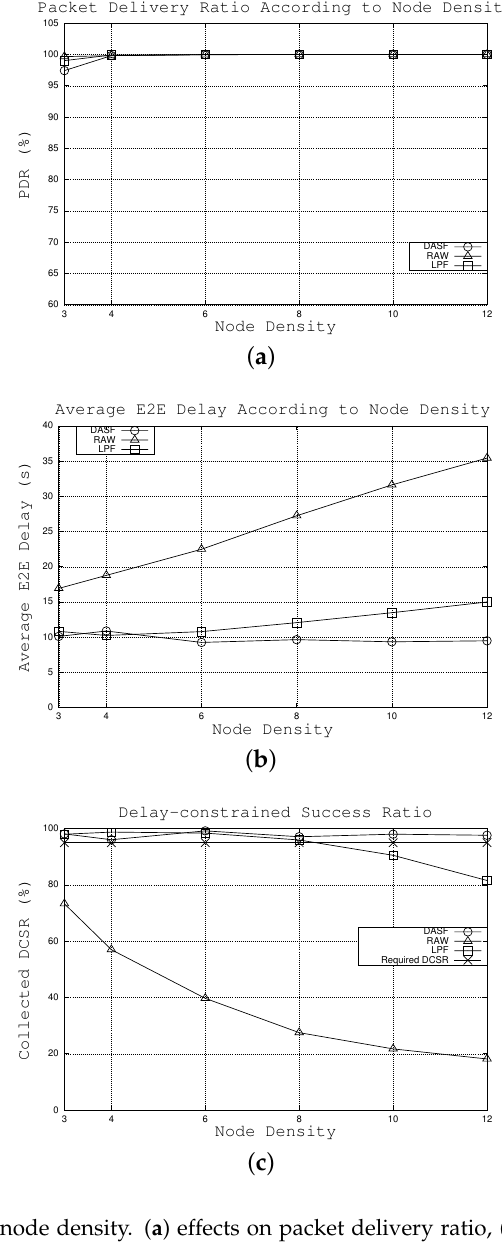
Figure 6. Effects of the node density. ( a ) effects on packet delivery ratio, ( b ) effects on average E2E delay, ( c ) effects on collected